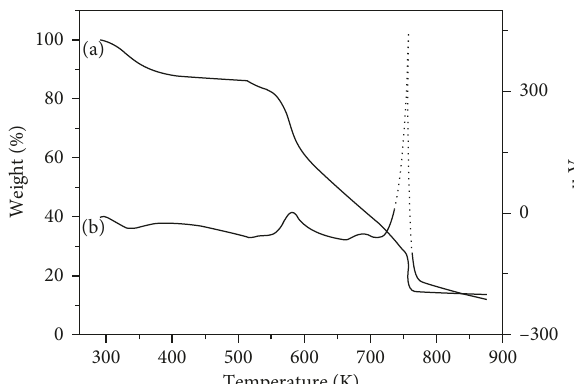
Figure 3: (a) TGA and (b) DTA plot of LISZn1 complex.